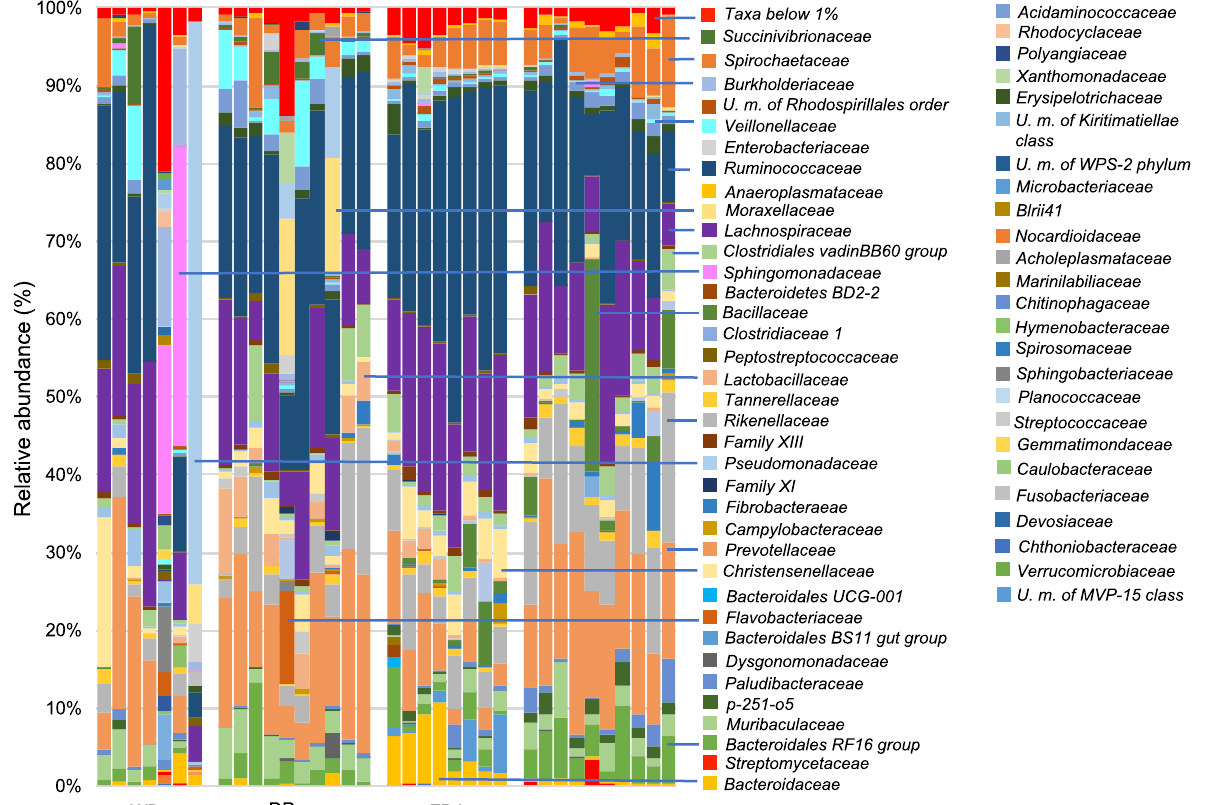
Fig. 2 Relative abundance (%) of family in each sample. The bars in the graph show the proportion of the sequences in each sample that can be classified at the family level. The blue lines indicate families that occur in at least one sample with a frequency of occurrence DP, domestic pig; FPJ, juvenile feral pig; FPA, adult feral pig